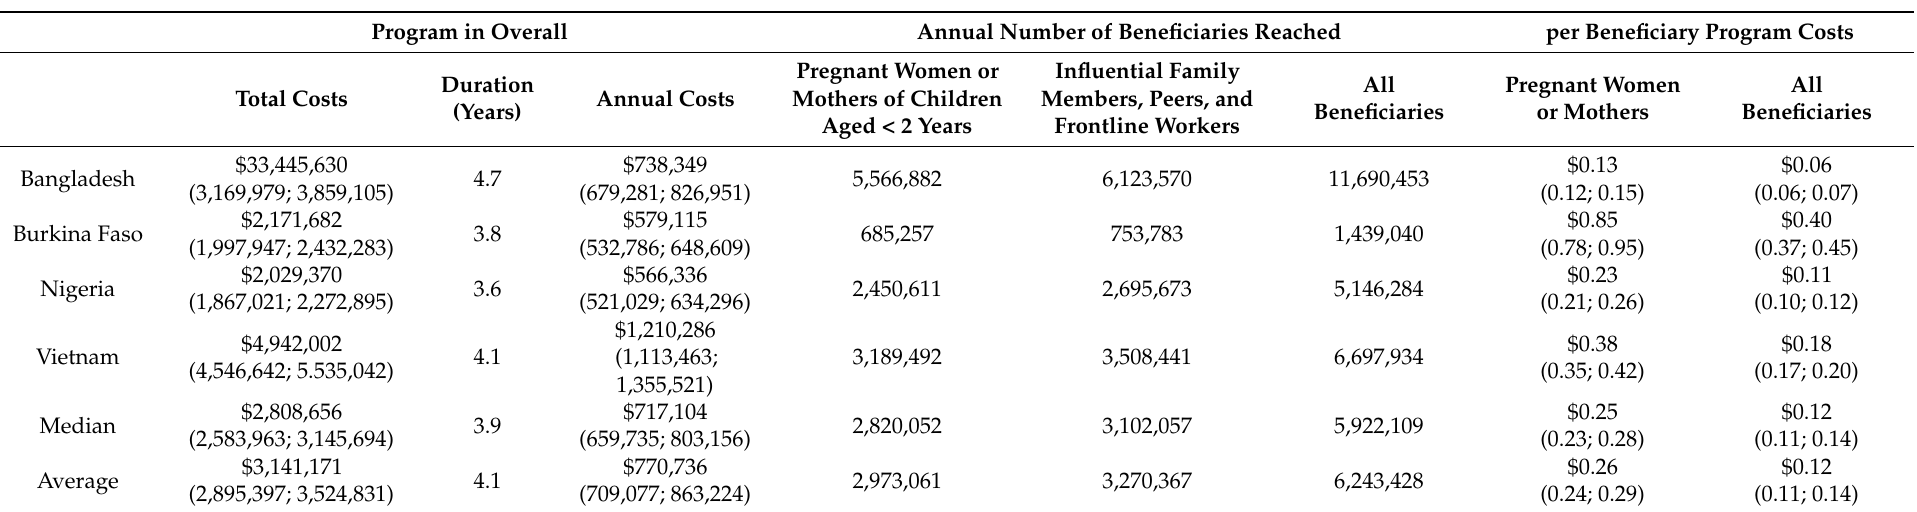
Table 3. Total and Annual Costs 1 , Beneficiaries 2 , and Cost Per Beneficiary by Country (2019 USD). Program in